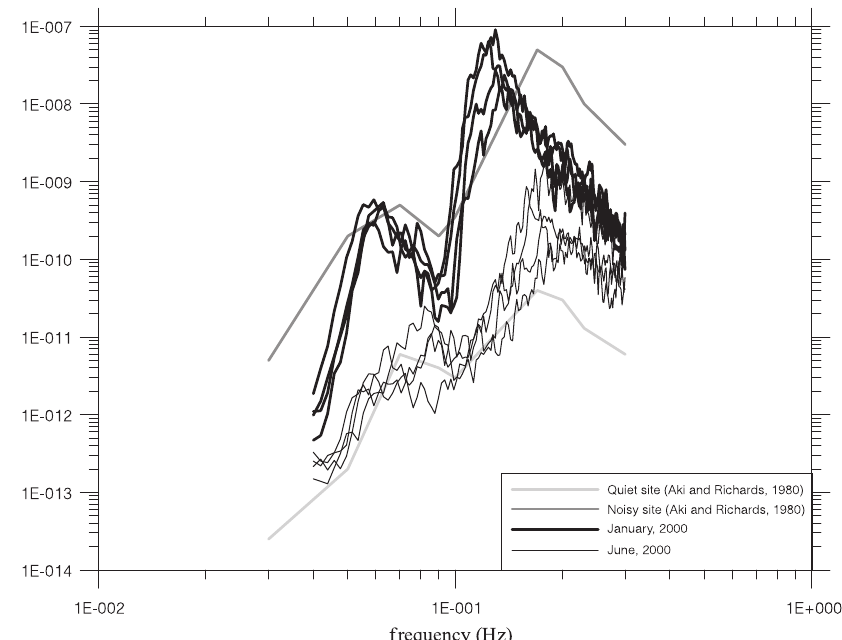
Fig. 6. Velocity power spectral density of vertical component primary and secondary microseisms (0.03 < f < 0.3 Hz) for January and June, 2000. Power spectra curves are compared with the high and low noise model according to Aki and Richards